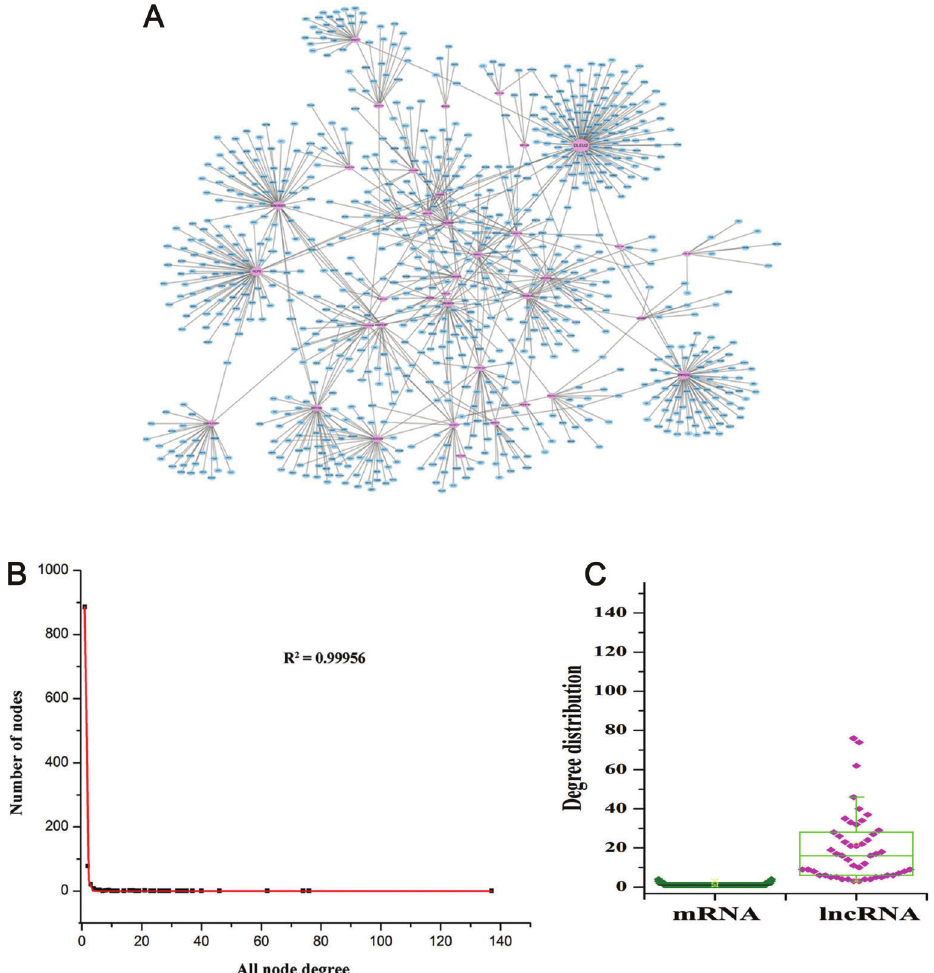
Figure 2. A , Highly competitive lncRNA-associated ceRNA network (LMCN). This network contained 55 lncRNAs, 982 mRNAs, and 1104 ceRNA interactions. Pink nodes denote lncRNAs, and blue nodes denote mRNAs. B , Degree analysis for the entire network reveals the speci fi c properties of the LMCN. C , lncRNA are more critical components relative to mRNA ceRNAs in the LMCN. The lncRNAs had signi fi cantly higher degrees than mRNAs in the LMCN ( t -test,